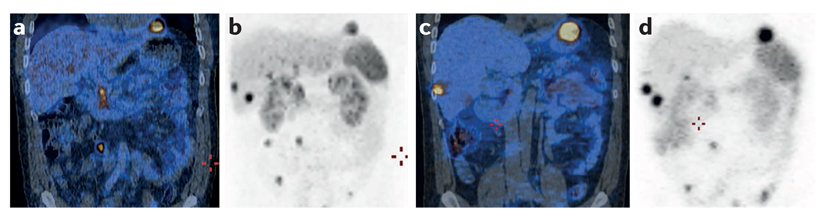
A patient with a metastatic neuroendocrine tumour undergoing a diagnostic 68Ga-dotatate PET–CT has a | multiple disease sites on fused coronal images, and b | maximum intensity projection. The patient then received therapeutic 177Lu-dotatate, which enables demonstration of drug uptake at the disease sites, confirmed by SPECT– CT examination on c | fused coronal images and d | maximum intensity projection.